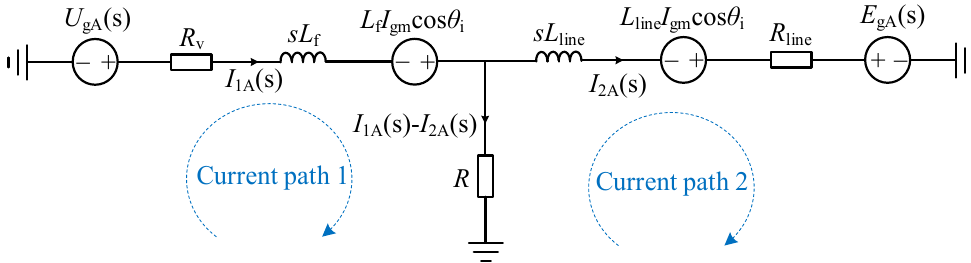
Figure 5. Equivalent circuit diagram of the grid-connected wind turbine system in the s domain after the three-phase short-circuit fault occurs.